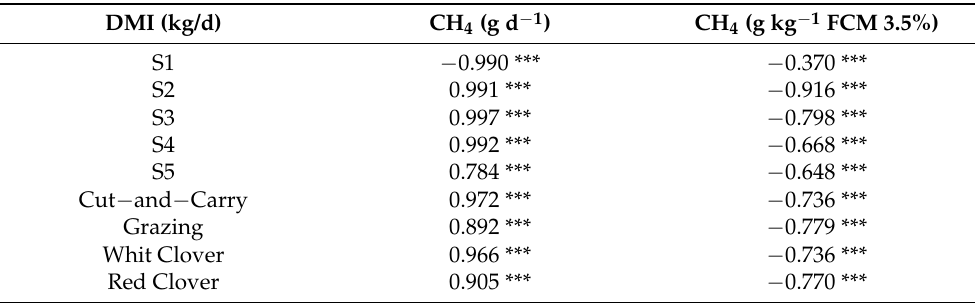
Table 9. Correlations among dry matter intake (DMI, kg/d) using different feeding strategies, five different supplementations (S) in dairy cattle under two feeding management systems (grazing or cut-and-carry), and two forage crops (red clover or white clover) compared with emissions of methane (CH 4 ) and carbon dioxide (CO 2